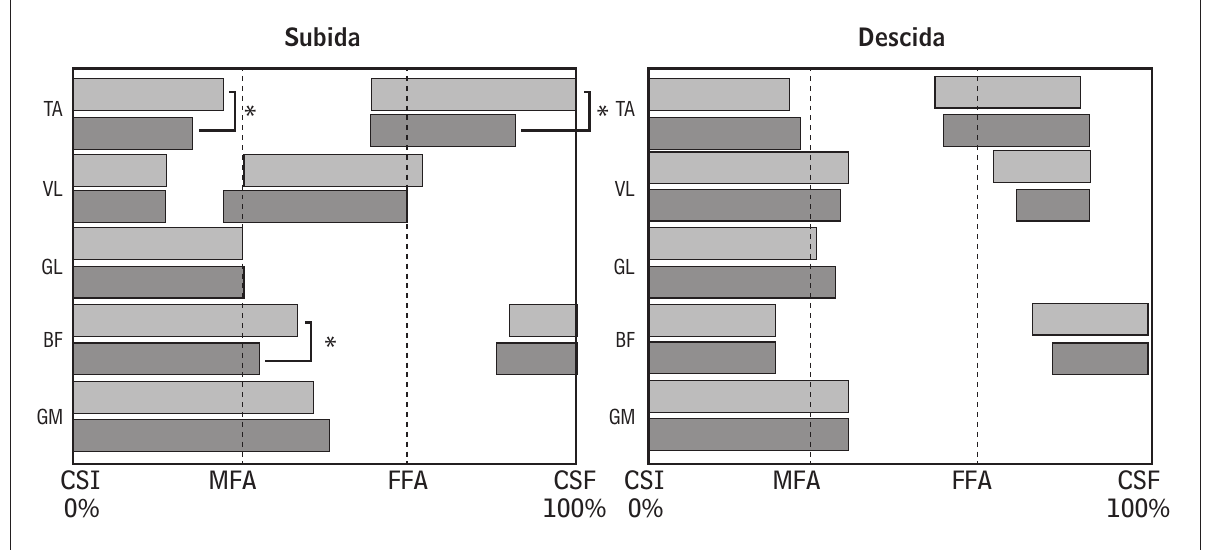
Figura 3 - Cronometria muscular na subida e na descida Nota: As barras identi fi cam o período de atividade muscular; PRÉ: barras claras; PÓS: barras escuras; CSI: contato com o solo inicial; MFA: meio da fase de apoio; FFA: fase fi nal de apoio; CSF: contato com o solo fi nal. TA = tibial anterior; VL = vasto lateral; GL = gastrocnêmio lateral; BF = bíceps femoral; GM = glúteo máximo; (*) = diferença signi fi cativa (p ≤